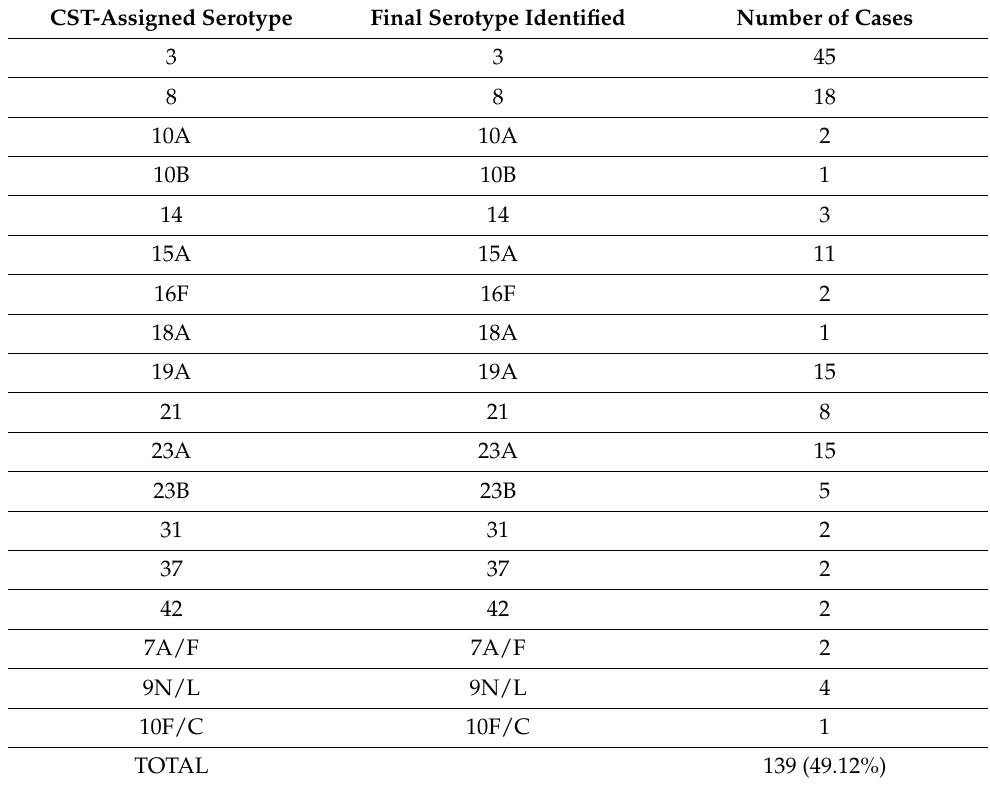
Table 3. Pneumococcal single serotype identification by the application of CST. CST-Assigned